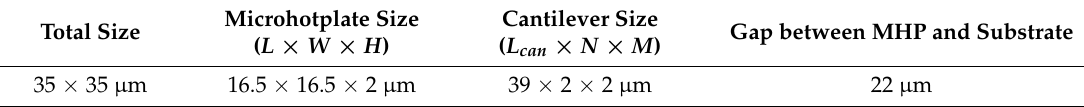
Table 1. Redesigned geometries of the micro-Pirani vacuum sensor.